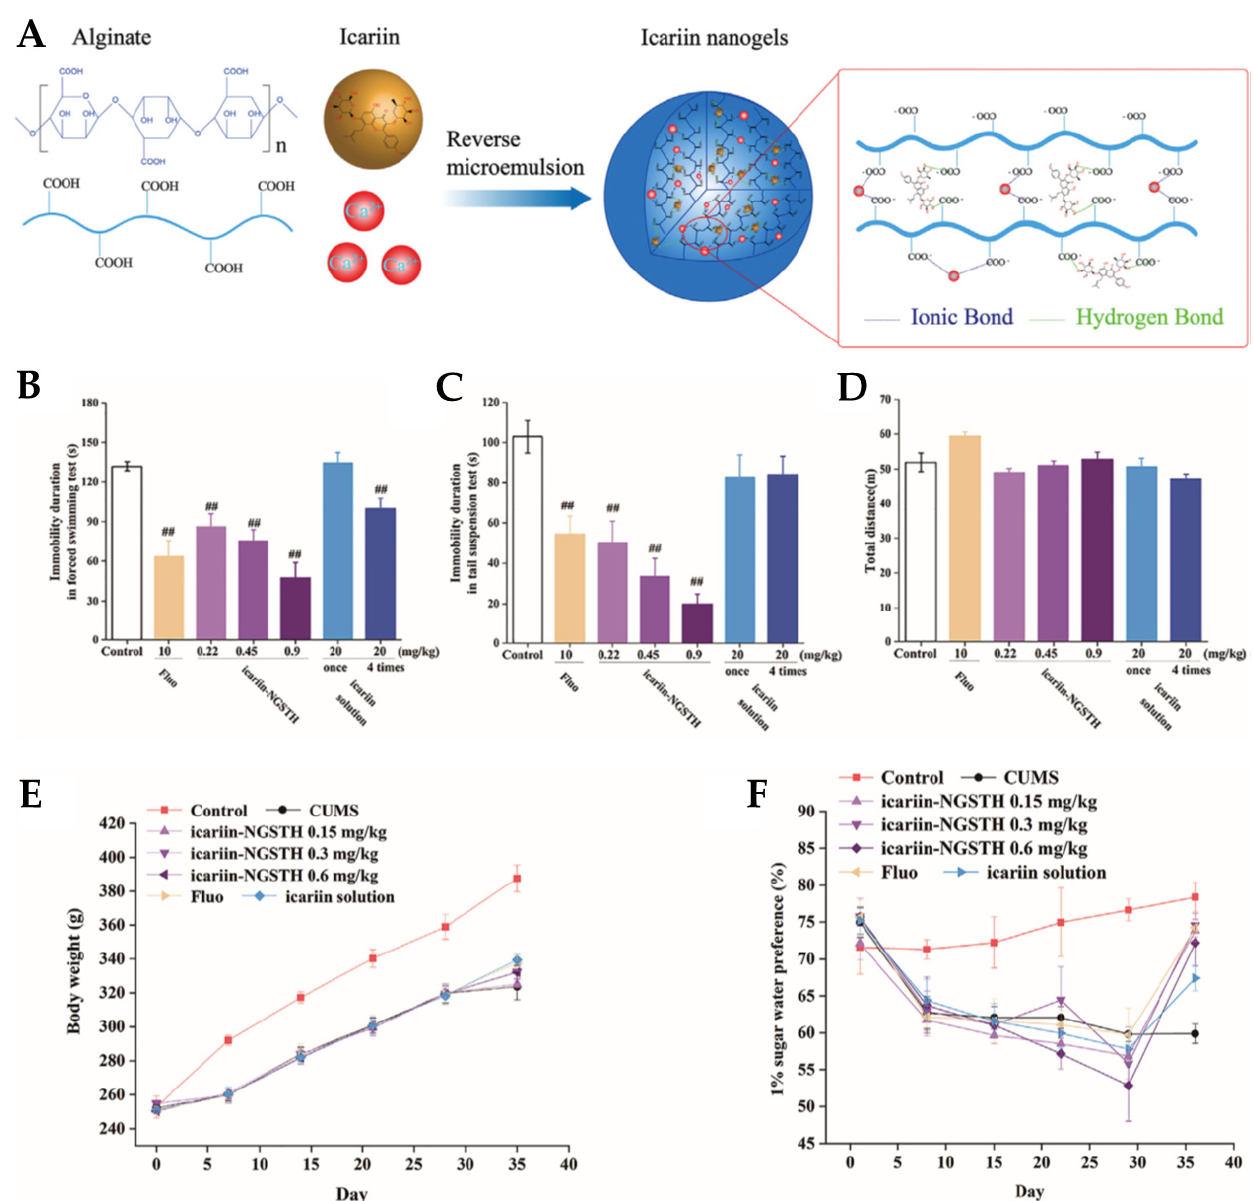
Figure 4. ( A )—Schematic representation of the making of icariin nanogels; ( B )—Immobility duration in a forced swimming test, ( C )—Immobility duration in tail suspension test, and ( D )—Total distance travelled in open field test, in mice, after intranasal administration of saline buffer (negative control), oral administration of a fluoxetine solution (Fluo, positive control), intranasal administration of the icariin nanogel (NGSTH), or oral administration of an icariin solution; ( E )—Changes in body weight, and ( F )—Changes in 1% sucrose preference, in rats, after no administration (CUMS) or intranasal administration of saline buffer (negative controls), oral administration of a fluoxetine solution (Fluo, positive control), intranasal administration of the icariin nanogel (NGSTH), or oral administration of an icariin solution; ## p < 0.01, compared with the negative control group; adapted from Xu et al. [54], reproduced with permission from Elsevier [License Number 5426000092048].